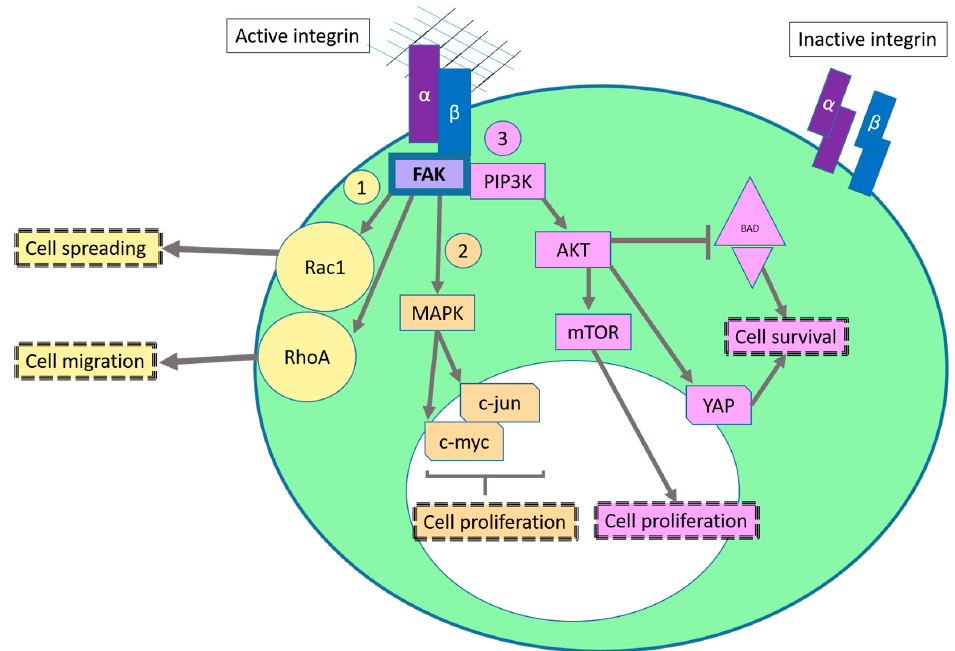
Figure 1. Schematic representation of the integrin outside-in signaling. Through the activation of focal adhesion kinase (FAK) via integrins, Src is activated (not shown). (1) Rac1 GTPase is recruited to the plasma membrane, GDP-GTP exchange occurs and controls actin assembly in nascent protrusions [11,27]. At later stages, RhoA activity increases, leading to the formation actin stress fibers and stimulates actomyosin contractility via its downstream effector Rho-associated protein kinase (ROCK) [28]; (2) Integrin mediated FAK activation triggers the mitogen-activated protein kinase (MAPK) pathway. Different transcription factors are phosphorylated, leading to the expression of pro-proliferation genes; (3) The PIP3K/AKT pathway activation leads to enhanced translation of pro-survival and pro-proliferation genes via the mammalian target of rapamycin (mTOR) pathway. The phosphatidylinositol-3-phosphate kinase/AKR mouse thymoma kinase (PIP3K/AKT) pathway cross-talk with the Hippo pathway via Yes-associated protein (YAP). YAP is a transcription factor that can induce for example expression of the anti-apoptotic proteins survivin and Bcl-xL [29]. (Of note, there are a plethora of cross-talks between all these pathways that are not discussed here for simplication purposes). Arrows: interaction with another protein or promotion of a specific cell behavior; T-bar: inhibition; dotted boxes: effect/consequence from the signaling cascade; big ellipse in green: cell; small ellipse in white: nucleus.